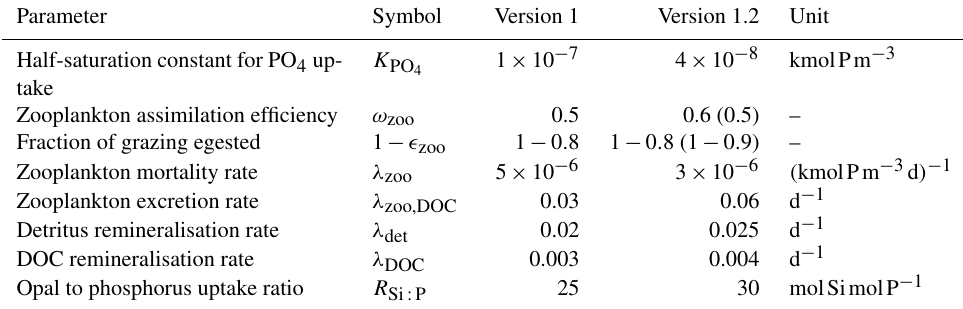
Table 2. Parameter values of the ecosystem parameterisation (see Maier-Reimer et al., 2005, for details) that have been changed between model versions 1 and 1.2. Parameter values in brackets have been used for the model runs with the non-standard sinking schemes (Sect. 3.5).